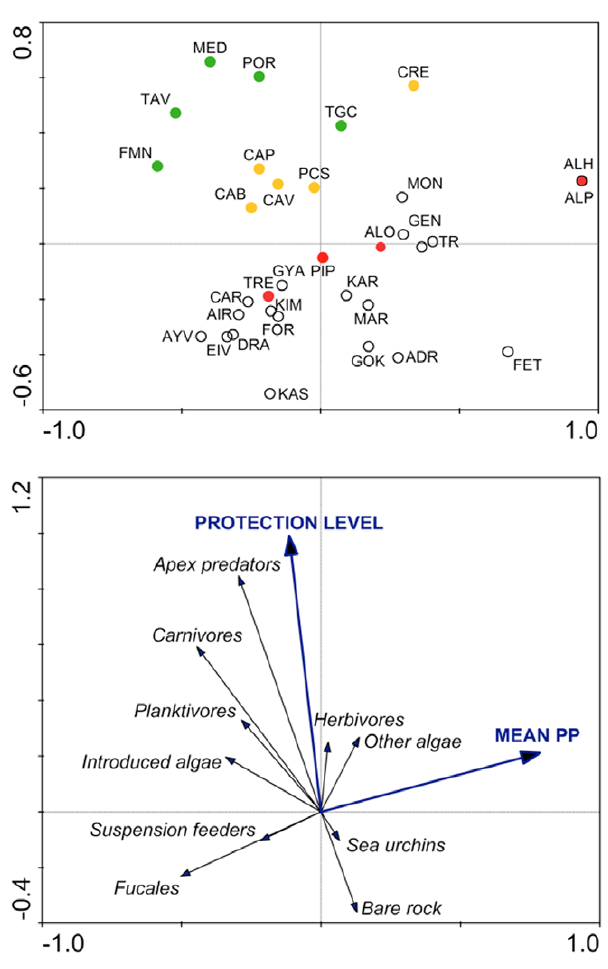
Figure 2. Biplot of results of redundancy analysis on biological and environmental data. Site codes as in Fig. 1. Green circles are well enforced no-take reserves, yellow circles are marine protected areas where some fishing is allowed or some fishing occurs due to weak enforcement, red circles are non-enforced MPAs, and white circles are unprotected, open access areas.